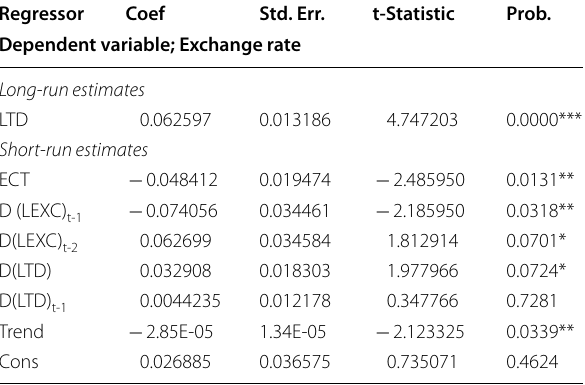
Table 5 Short-run estimates based on PMG for India